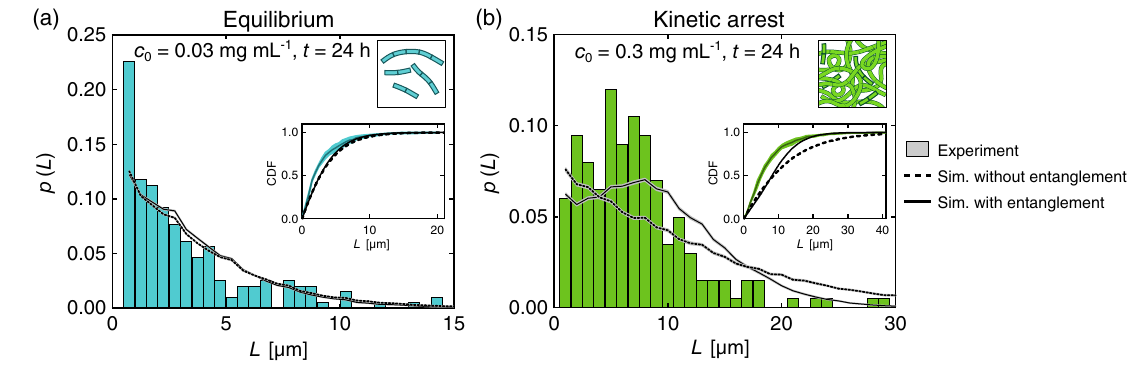
FIG. 3. Length distributions after 24 h assembly. (a) Low-concentration regime with initial concentration c 0 ¼ 0 . 03 mg mL − 1 and assembly duration of 24 h; (b) high-concentration regime with initial concentration c 0 ¼ 0 . 3 mg mL − 1 and assembly duration of 24 h. Because of limitations in fluorescence imaging, the filaments with L < 0 . 5 μ m are excluded from both experiments and theory. Sample size: ∼ 200 filaments. The theoretical curves have been obtained from two simulation models and averaged over 20 independent simulations. Dashed lines show the distribution when only considering annealing and fragmentation. Solid lines show the distribution with the addition of entanglement. Insets: cumulative distribution functions (CDF) of the filament lengths averaged over 3 experimental repeats at c 0 ¼ 0 . 03 mg mL − 1 (cyan) and c 0 ¼ 0 . 3 mg mL − 1 (green), averaged over 20 simulations without (dashed black lines) and with entanglement (solid black lines). The filled area around the lines depicts the standard deviation over the 20 simulations or 3 experimental repeats. The experimental and simulated distributions were found to be nonsignificantly different at the 5% level using the Kolmogorov-Smirnov test (statistics D ¼ 0 . 11 without and D ¼ 0 . 10 with entanglement are above 0.05 for c 0 ¼ 0 . 03 mg mL − 1 and an experimental sample size of 675; D ¼ 0 . 23 without and D ¼ 0 . 21 with entanglement are above 0.04 for c 0 ¼ 0 . 3 mg mL − 1 and a sample size of